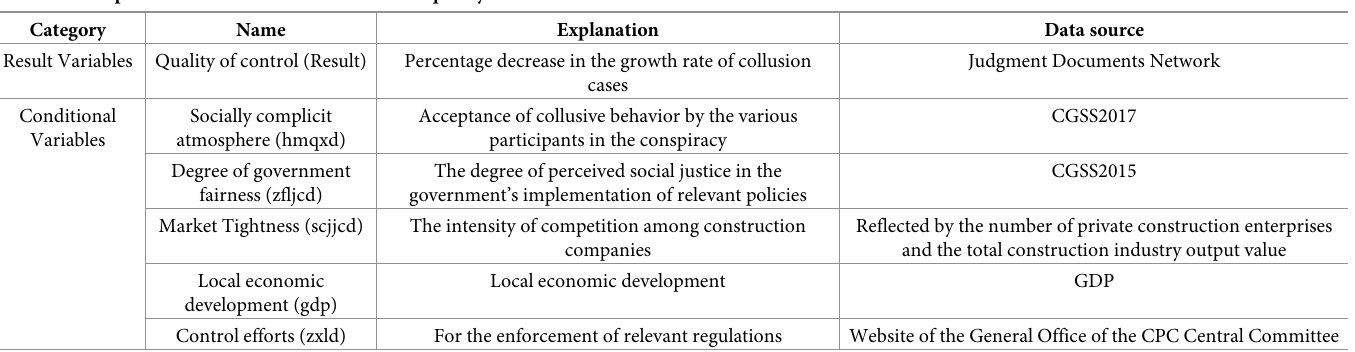
Table 3. Interpretation of vertical collusion control quality variables.